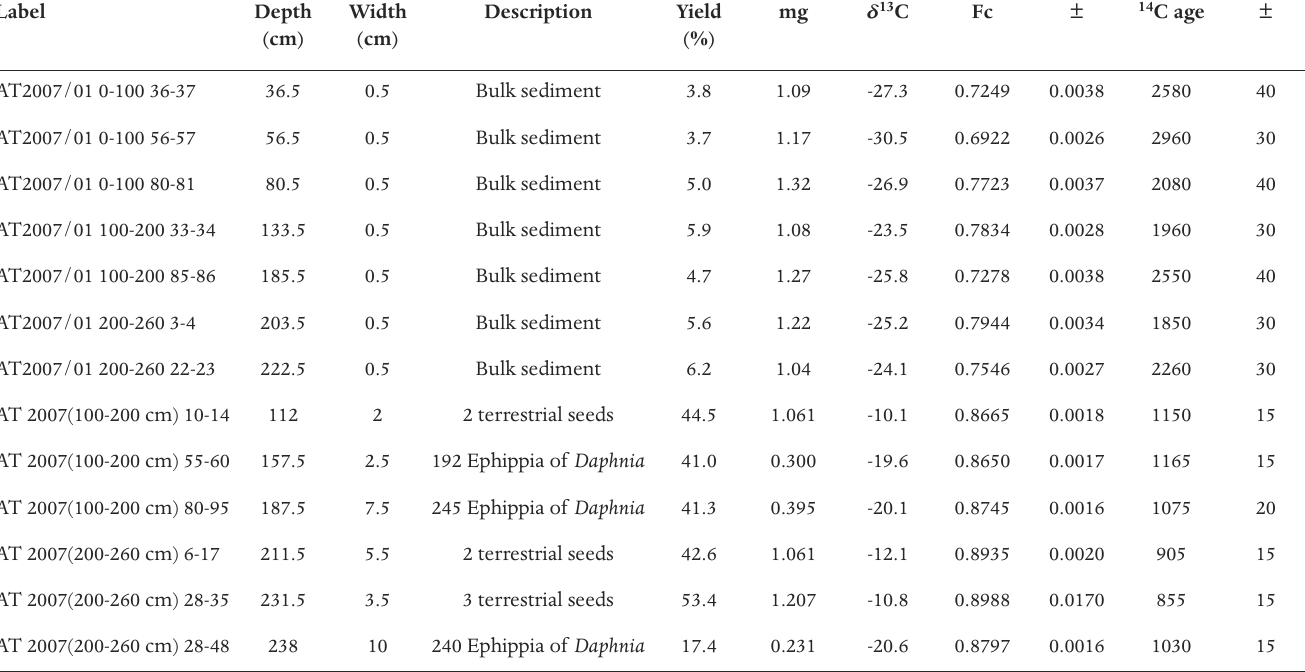
Table 1. Radiocarbon ages from the AT2007LG